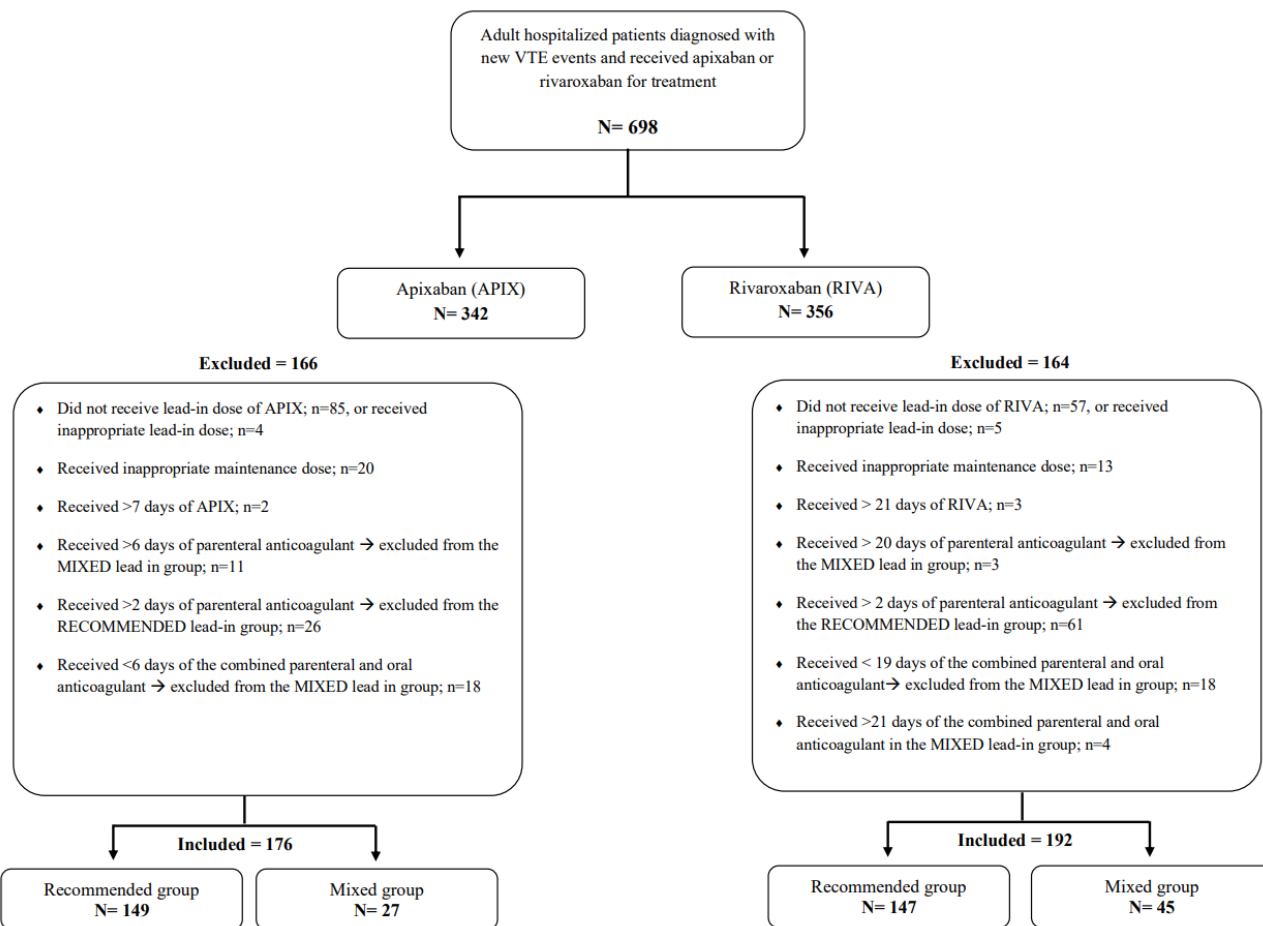
Figure 1. Flow diagram of included and excluded patients in the study. Abbreviations: VTE: